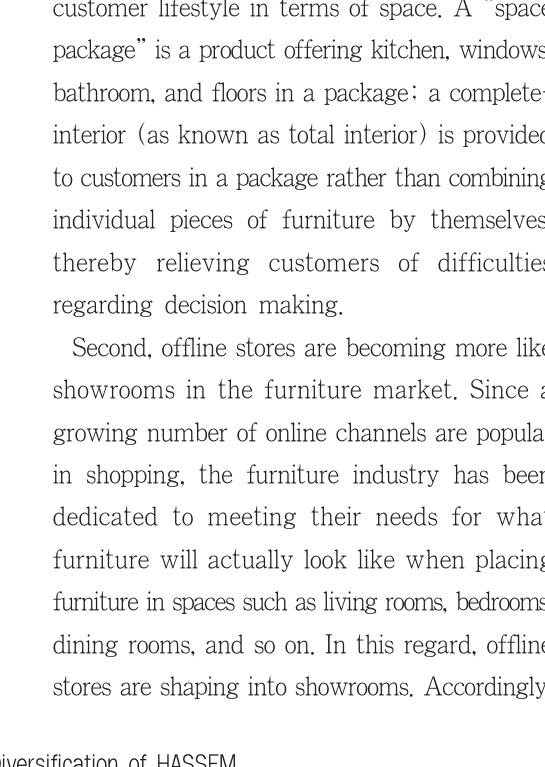
<Figure 2> Channel Diversification of